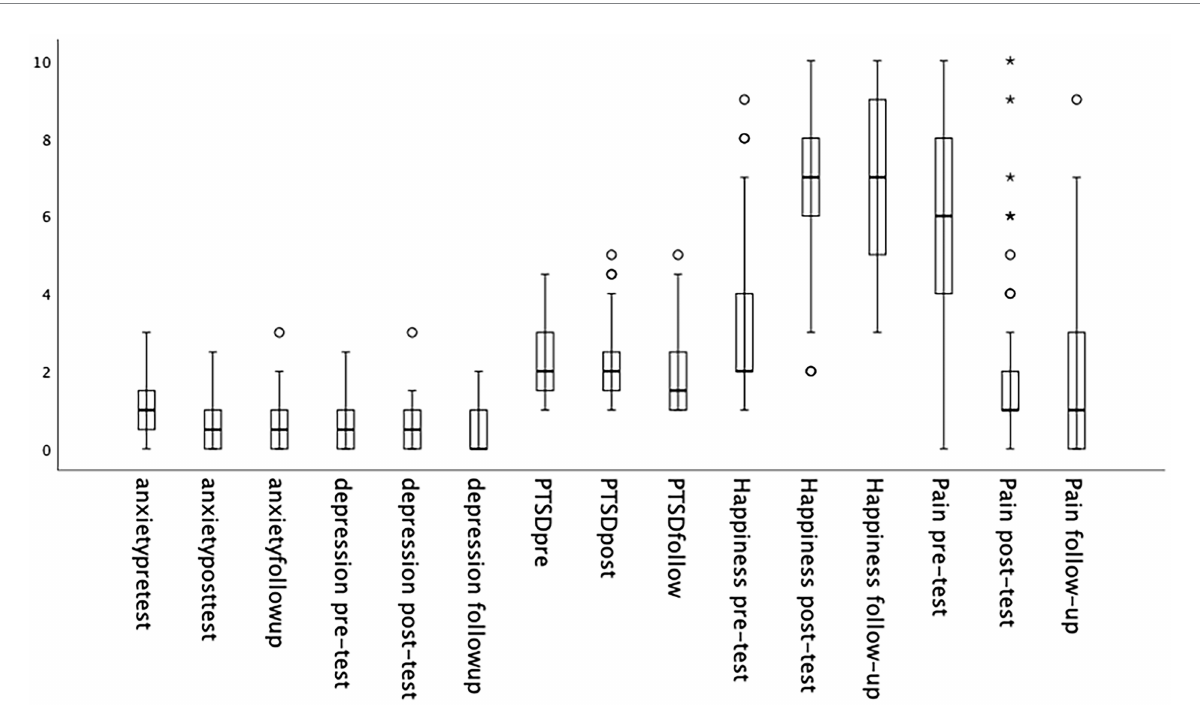
FIGURE 3 The distribution of data and outliers present across psychological markers across time ( N = 151).